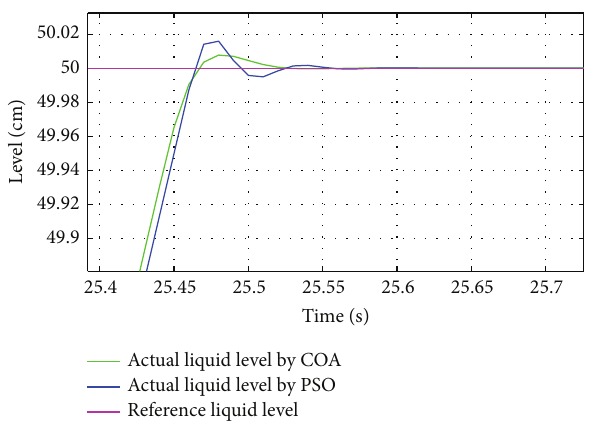
Figure 11: Response of fuzzy controller tuned using COA and PSO (level set: 50 cm at 𝑡 = 20